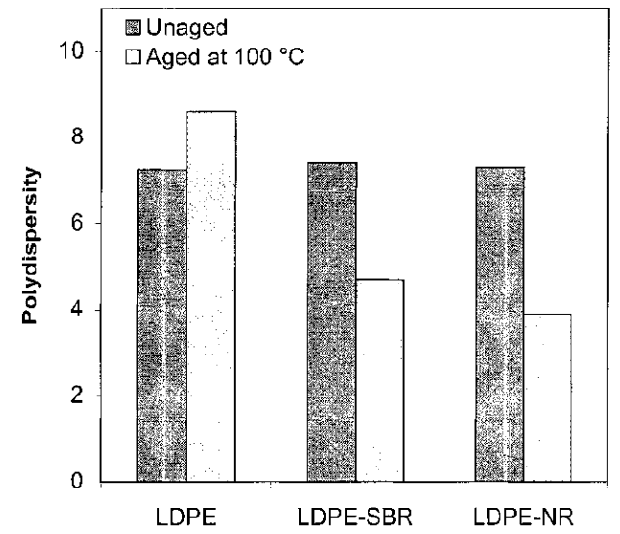
Figure 3. Polydispersity of unaged samples and samples aged at 100 ℃ for 14 days (Reproduced with permission [33]).